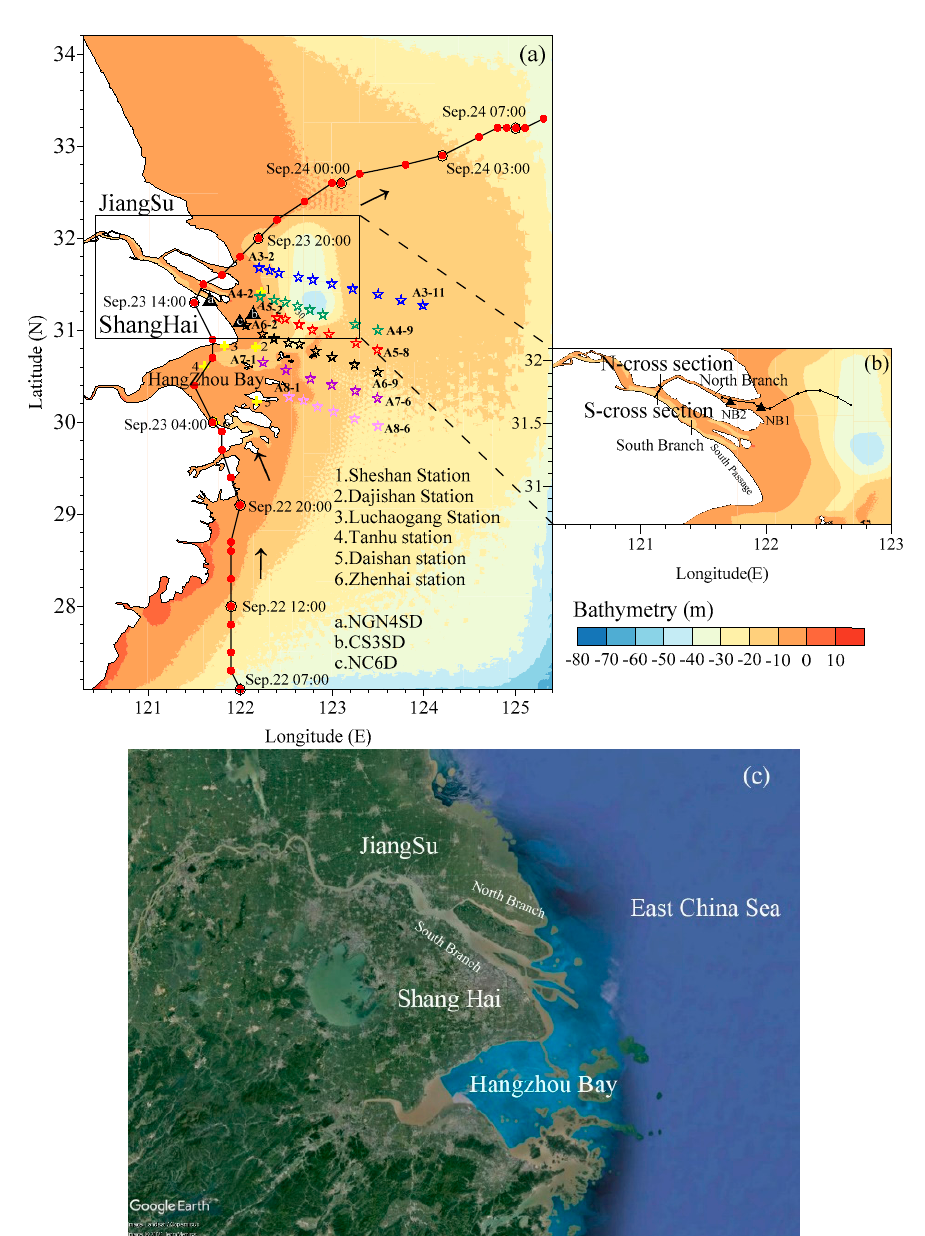
Figure 1. ( a ) The computational area of the YRE and the path of Typhoon Fongwong. The red circles and arrows are the typhoon center and moving direction. Purple cross-shapes are locations of six tidal gauge stations. Three black triangles mark the tidal current measurement locations in February 2014. Colored star symbols signify the cruising survey stations in July 2014. ( b ) The focused investigational area of the NB with two selected cross-sections of the NB and the SB at separation point, and talweg of the NB. Two black solid triangle points NB1 and NB2 are located at the mouth and the middle of the NB, respectively. ( c ) The map of the study area is downloaded from the Google